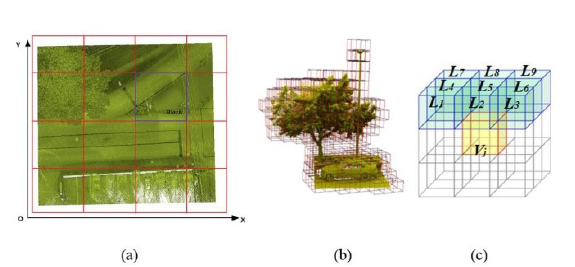
Figure 4. Principle of the voxel-based upward-growing